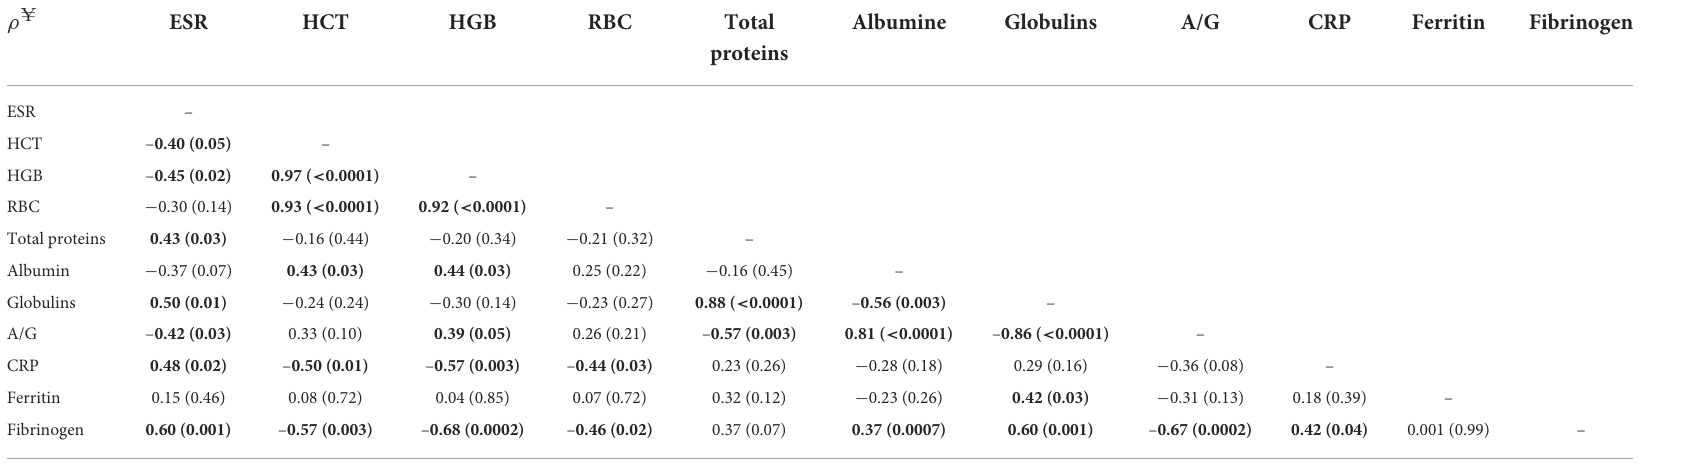
TABLE 5 Correlation matrix between ESR, HCT, HGB, RBC, A/G, CRP, ferritin, and fibrinogen in dogs affected by a CanL active form ( n =